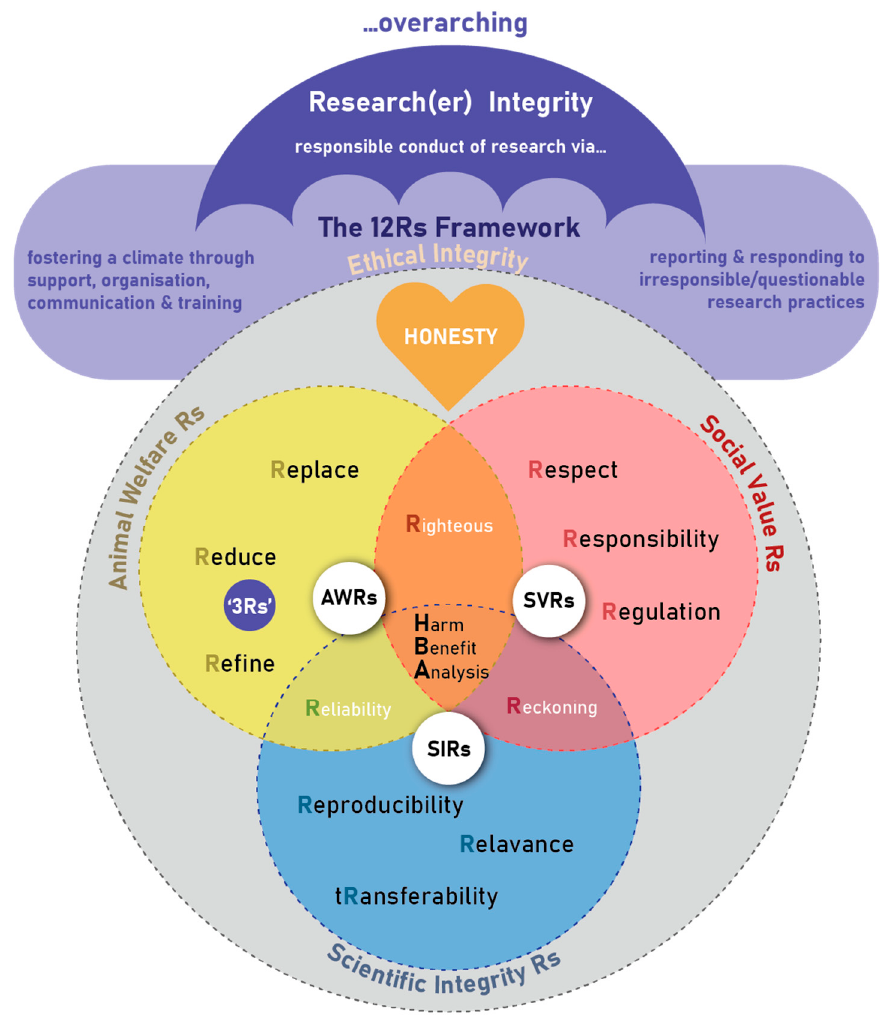
Figure 1. The 12 Rs framework for the ethical use of animals in research ethics: a birds-eye view.